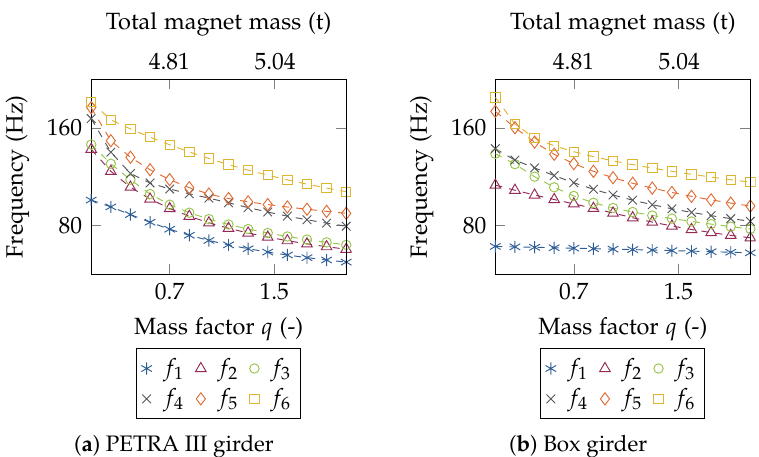
Figure 19. First six eigenfrequencies of the magnet–girder assembly with the PETRA III girder ( a ) and the box girder ( b ) depending on the magnet mass factor q , which was multiplied with the given magnet masses. In addition, the upper (second) horizontal axis of each plot shows the total mass of all eight magnets that altered with the varying factor q .